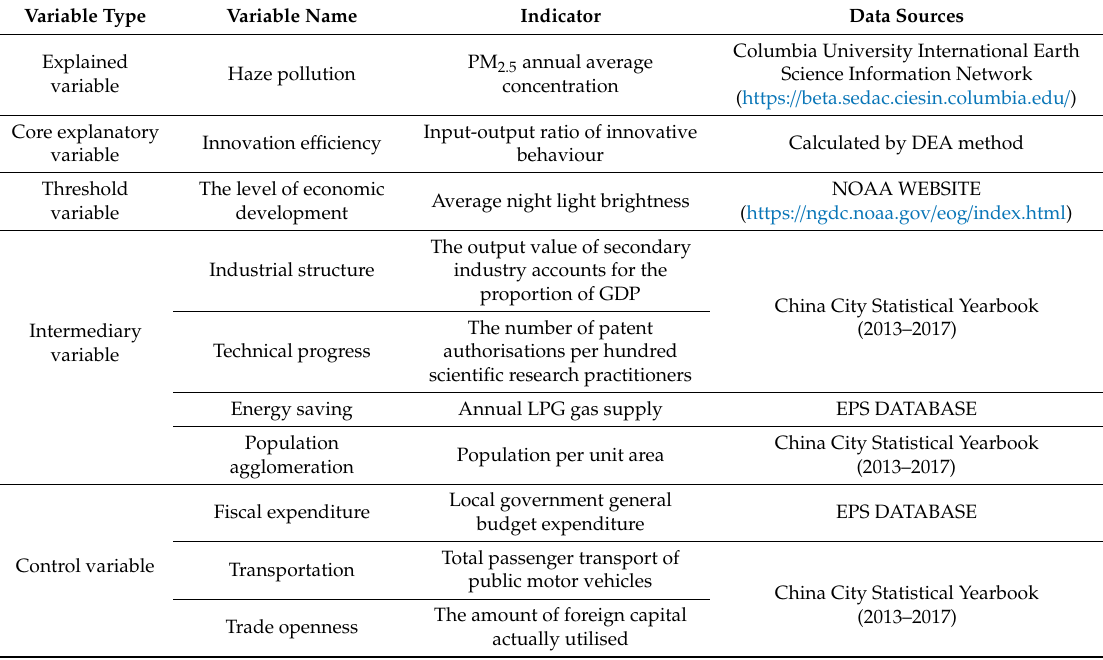
Table 1. Variable description and data